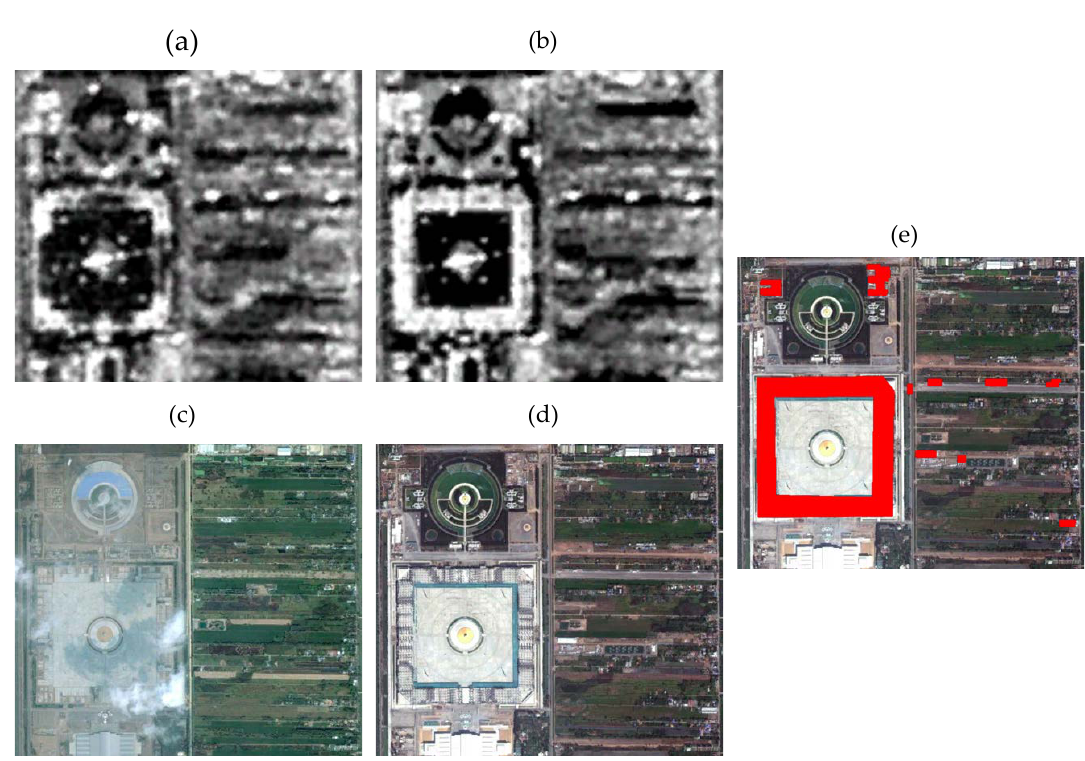
Figure 1. Examples of synthetic-aperture radar (SAR) dataset and ground truth data (red polygons) overlaid on an optical image from Google Earth of a temple construction in Bangkok: ( a ) SAR image from 12 January 2009, ( b ) SAR image from 21 November 2009, ( c ) optical image from 10 February 2005, ( d ) optical image from 18 December 2009, ( e ) created ground truth.